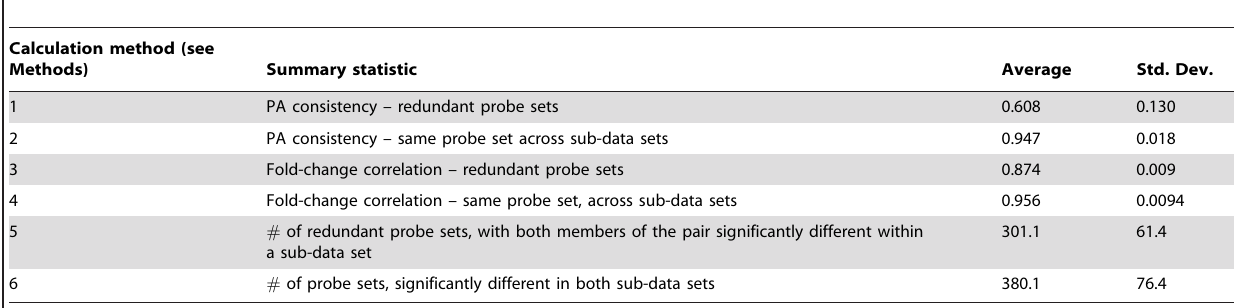
Table 4. Comparison of consistency across sub data sets and consistency across redundant probe sets based on re-sampling.